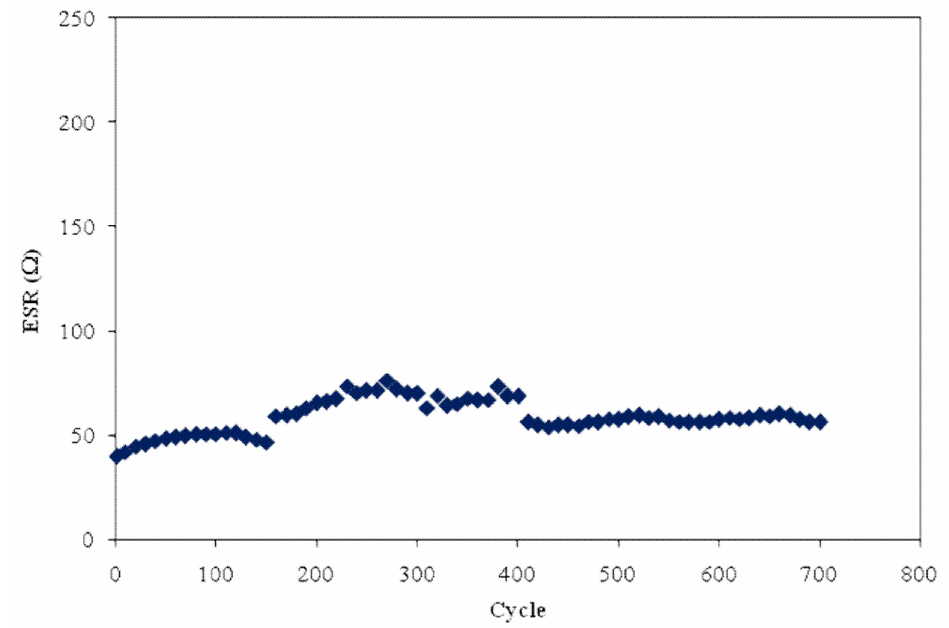
Figure 11. Equivalent series resistance (ESR) of the fabricated EDLC for 700